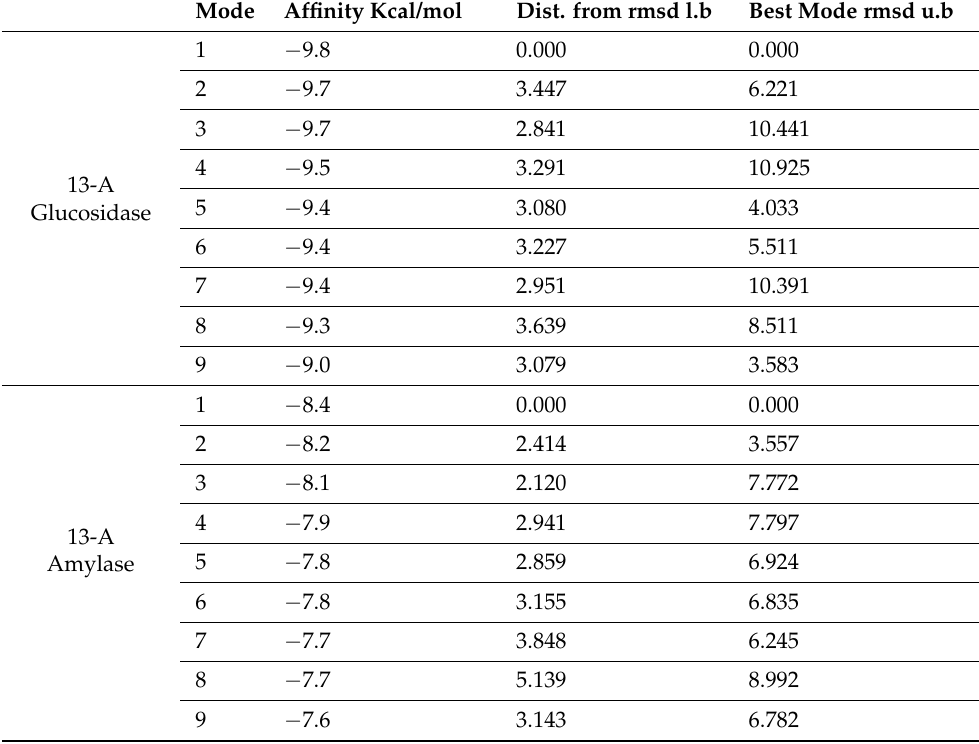
Table 2. Showed nine different poses of analogue 13 with varied binding affinity.